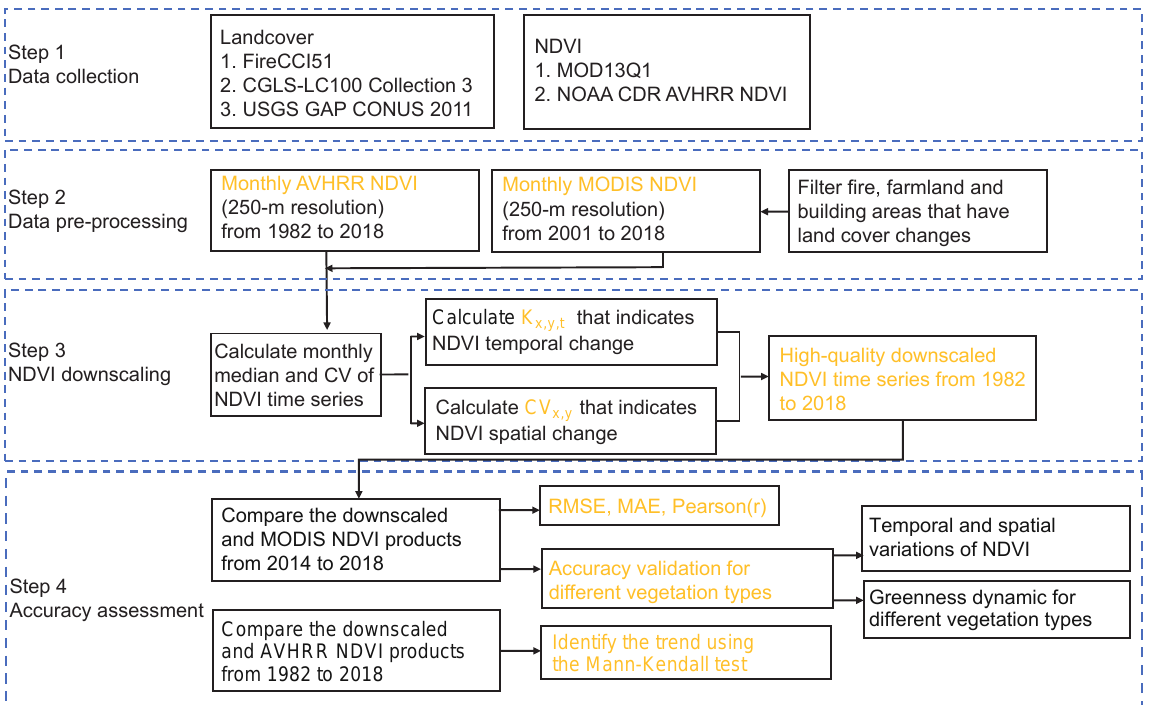
Figure 1. Processes of the downscaling